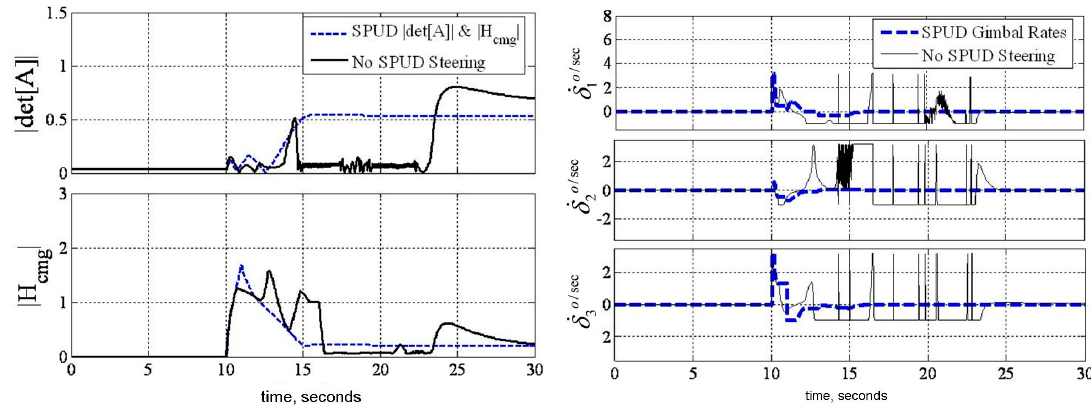
Figure 7. SIMULATION: Empirical data verifying the efficacy of SPUD.